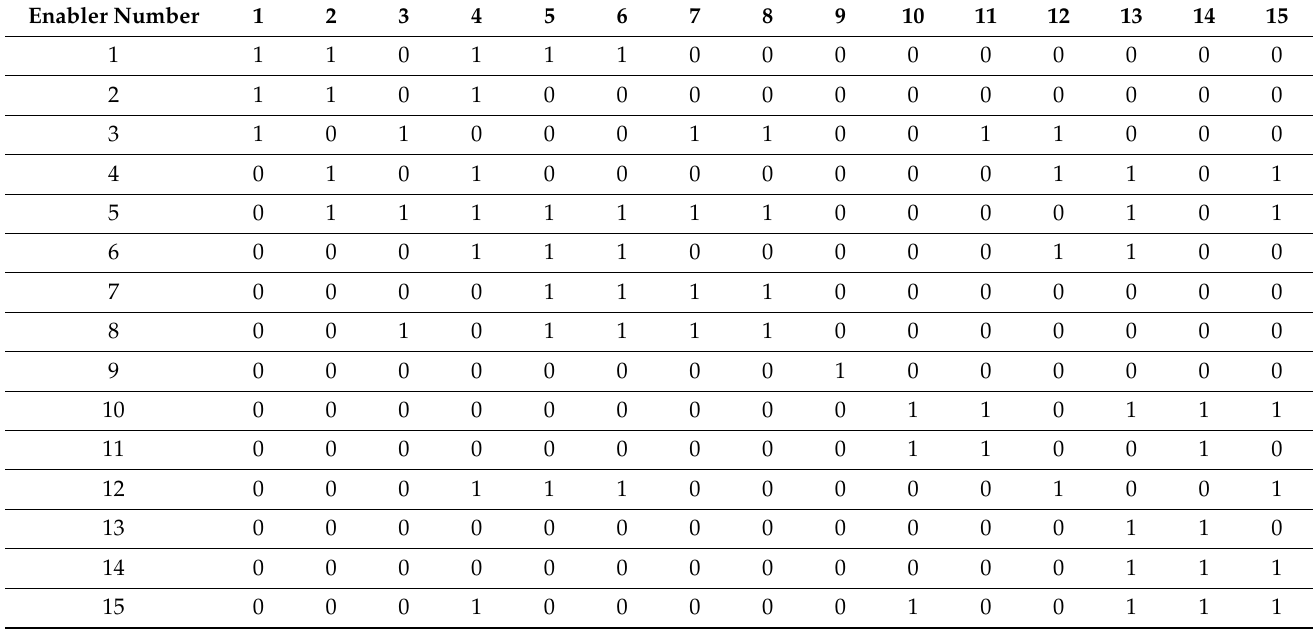
Table 5. Initial reachability matrix